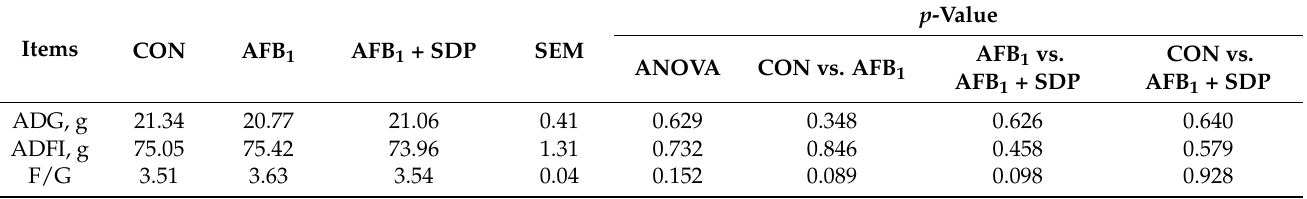
Table 1. The impacts of polysaccharides from seaweed ( Enteromorpha prolifera ) on growth performance of broiler chickens exposed to AFB 1 .